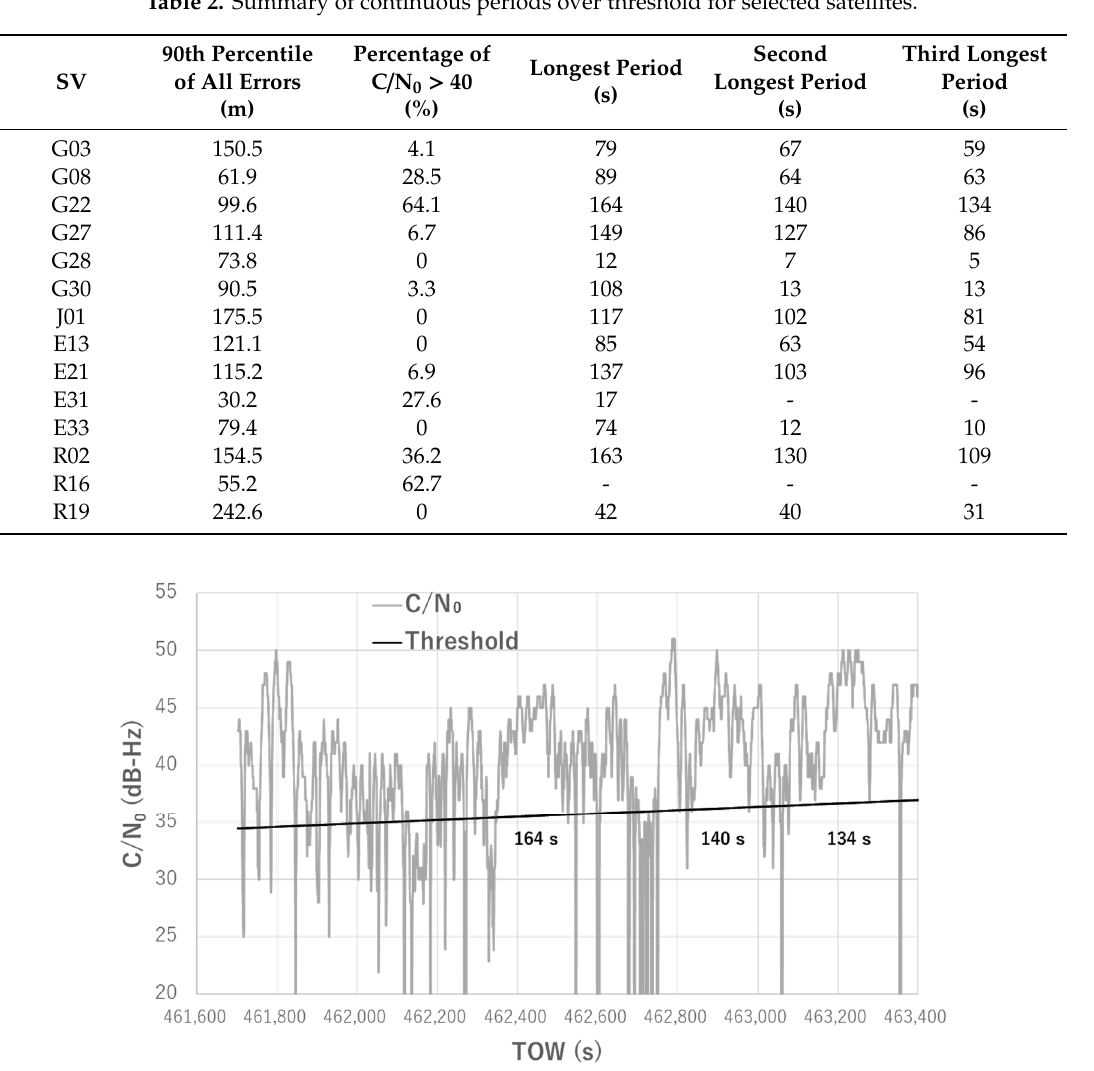
Table 2. Summary of continuous periods over threshold for selected satellites.